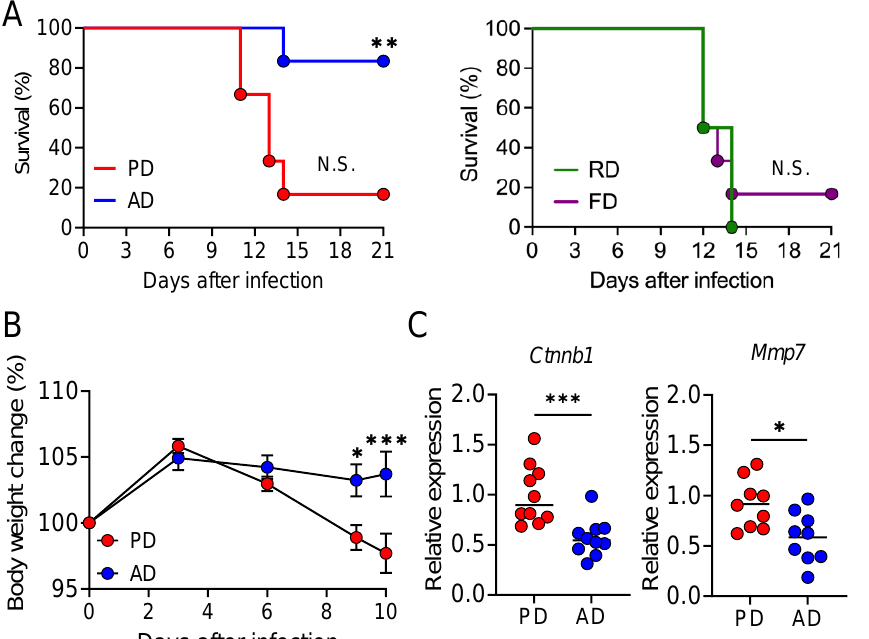
Figure 1. An amino acid-based diet protects mice from lethal infection with Citrobacter rodentium . Mice fed each diet (RD: regular natural diet ( n = 10), PD: regular purified diet ( n = 10), AD: amino acid-based purified diet ( n = 10), FD: purified high-fat diet ( n = 10)) were orally administered C. rodentium . ( A ) Mouse survival and ( B ) body weight change 3, 6, 9, and 10 days post-infection compared to that on day 0. Data are expressed as mean ± SEM. ( C ) Gene expression of Ctnnb1 and Mmp7 in the colon 9 days post-infection by real-time RT-PCR. mRNA expression of each gene was normalized to that of Rpl19 . Each dot represents an individual mouse, and horizontal bars indicate mean values. Statistical significance was assessed by the ( A ) log-rank test, compared to RD group, ( B ) two-way ANOVA with Šídák’s multiple comparisons test, or ( C ) unpaired Student’s t -test. * p < 0.05; ** p < 0.01; *** p < 0.001; N.S., not significant.